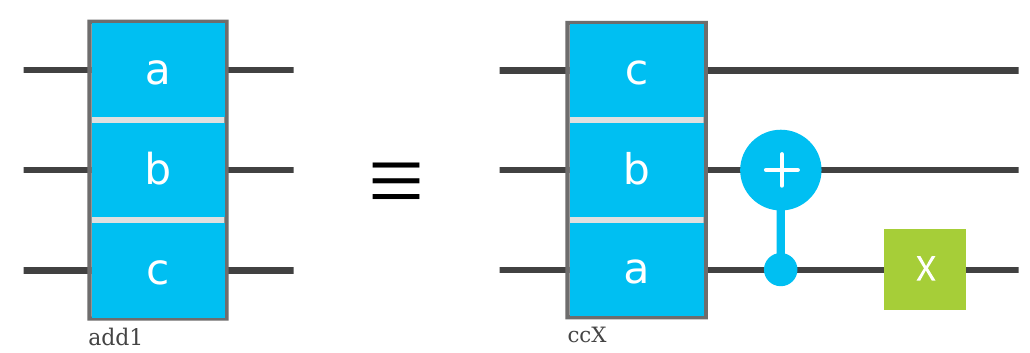
Figure 8. The “add 1” subroutine, to add one to a three-bit binary number. The number is denoted by the qubits as ( abc ) b . As explained before (Figure 5b), the “ccX” gate is the Toffoli gate in IBM quantum score with a and c are control qubits while c is the target. The green X gate is the quantum NOT gate, which simply flips the quantum state.